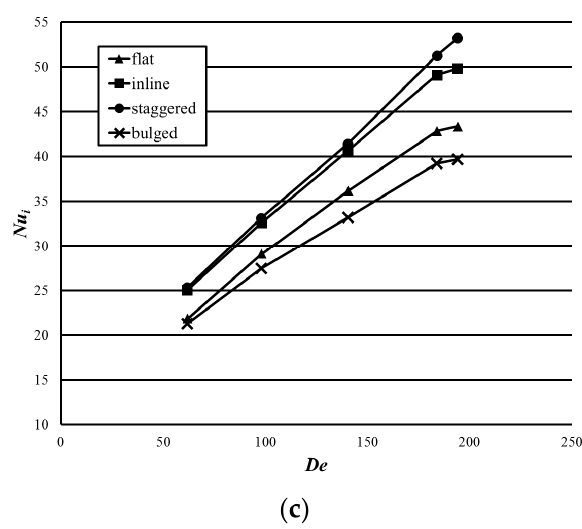
Figure 9. Nusselt number inside the helically-coiled tube with various De: ( a ) T hot, in = 45 ℃ ; ( b ) T hot,in = 55 ℃ ; and ( c ) T hot,in = 70 ℃ .